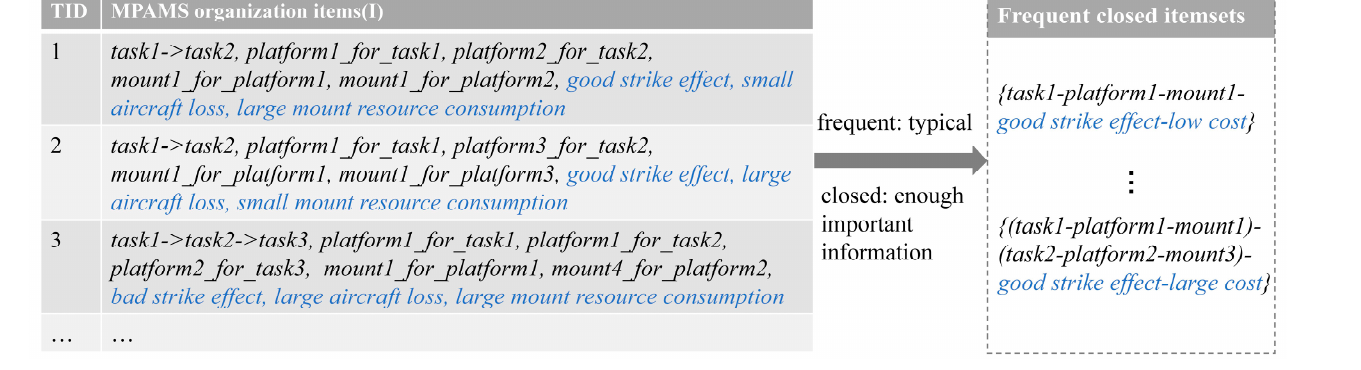
Figure 3. Problem description of the MPAMS organizational knowledge mining.